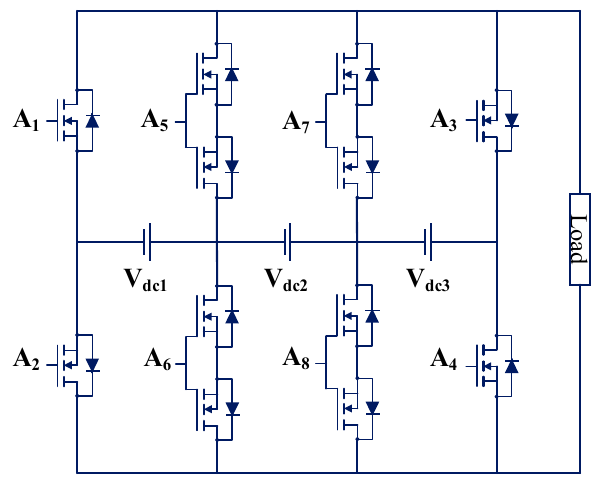
Figure 30. Single-phase FT MLI (TP33) [65].